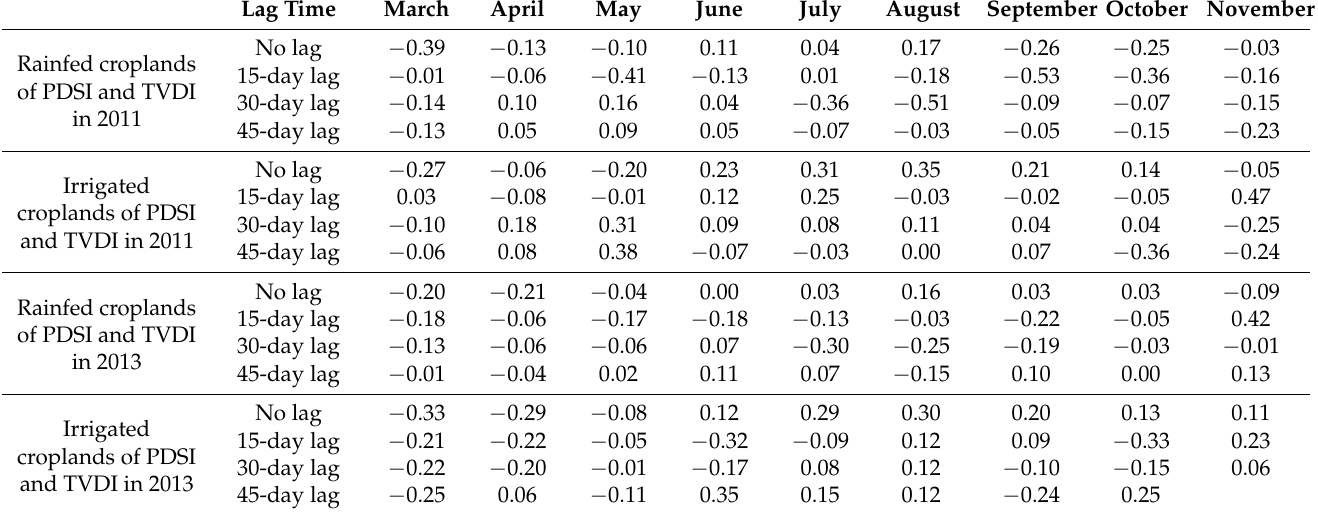
Table 4. The correlation coefficients between the PDSI and